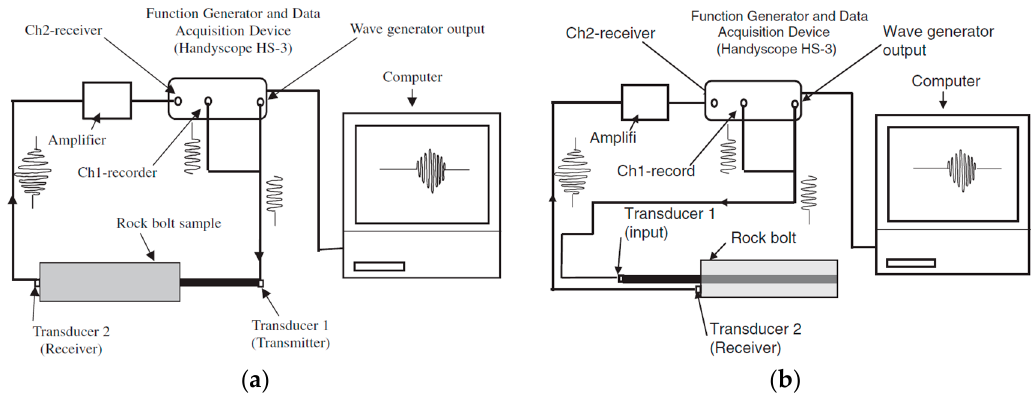
Figure 18. Equipment setup for the rock bolt test: ( a ) transmission-through setup [62], ( b ) transmission-echo-off-path setup